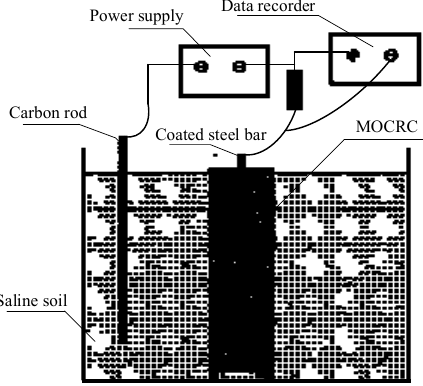
Figure 1. Schematic chart of electri fi ed accelerated corrosion system.